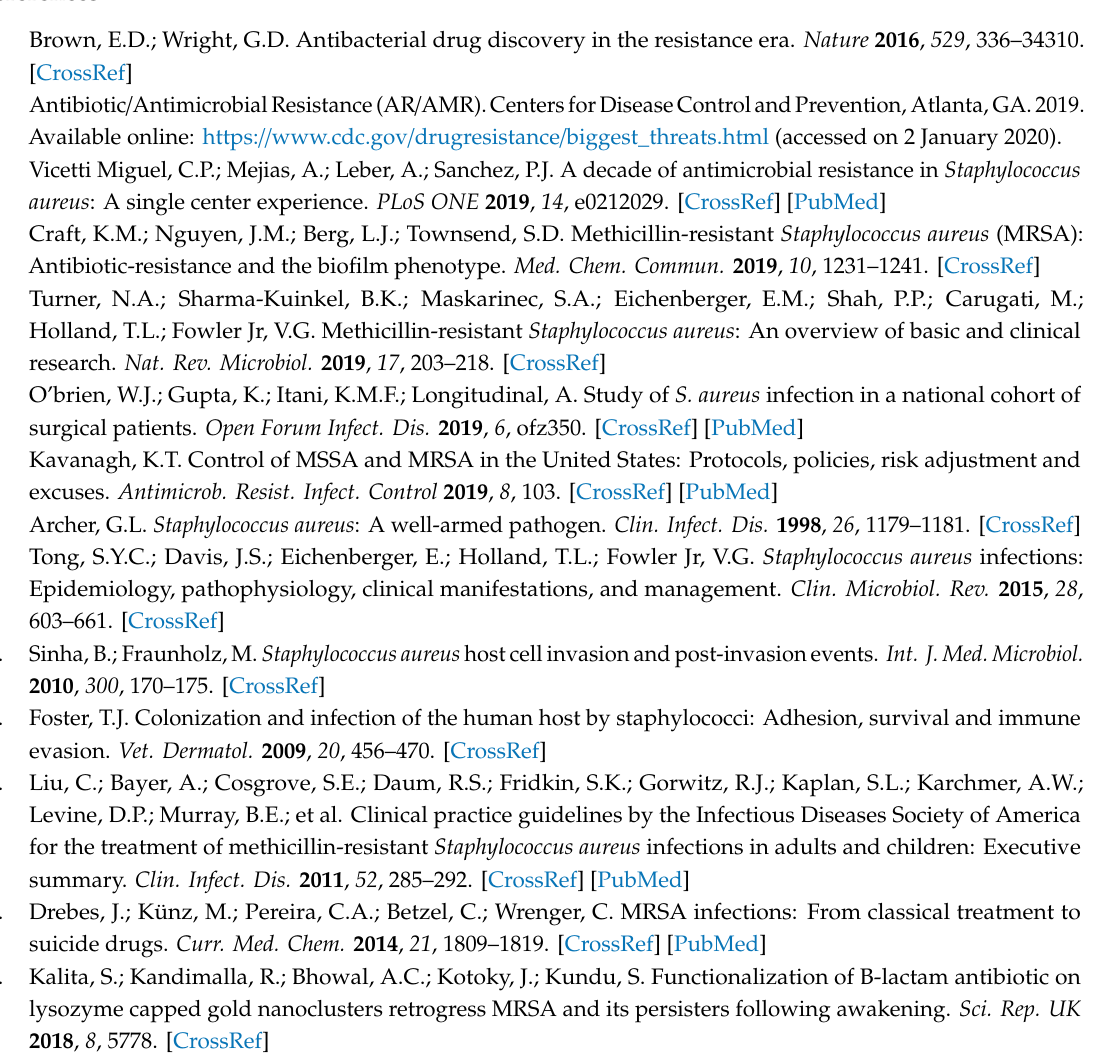
Supplementary Materials: The following are available online, Figure S1: Inhibition of decatenation activity of S. aureus topoisomerase IV by compounds 1 – 5 and levofloxacin. Figure S2: Inhibition of decatenation activity of S. aureus topoisomerase IV by compounds 6 – 9 and levofloxacin. Figure S3: Inhibition of decatenation activity of S. aureus topoisomerase IV by compounds 1 – 9 and ciprofloxacin. Figure S4: The TLC (thin layer chromatography) chromatograms for 4-benzoylthiosemicarbazides ( 1 – 5 ) and 4-arylthiosemicarbazides ( 6 – 9 ). Table S1: Antibacterial data (MIC, µ g / mL) for 4-benzoylthiosemicarbazides 1 – 5 , 4-arylthiosemicarbazides 6 – 9 , and antibiotics against clinical isolates of S. aureus